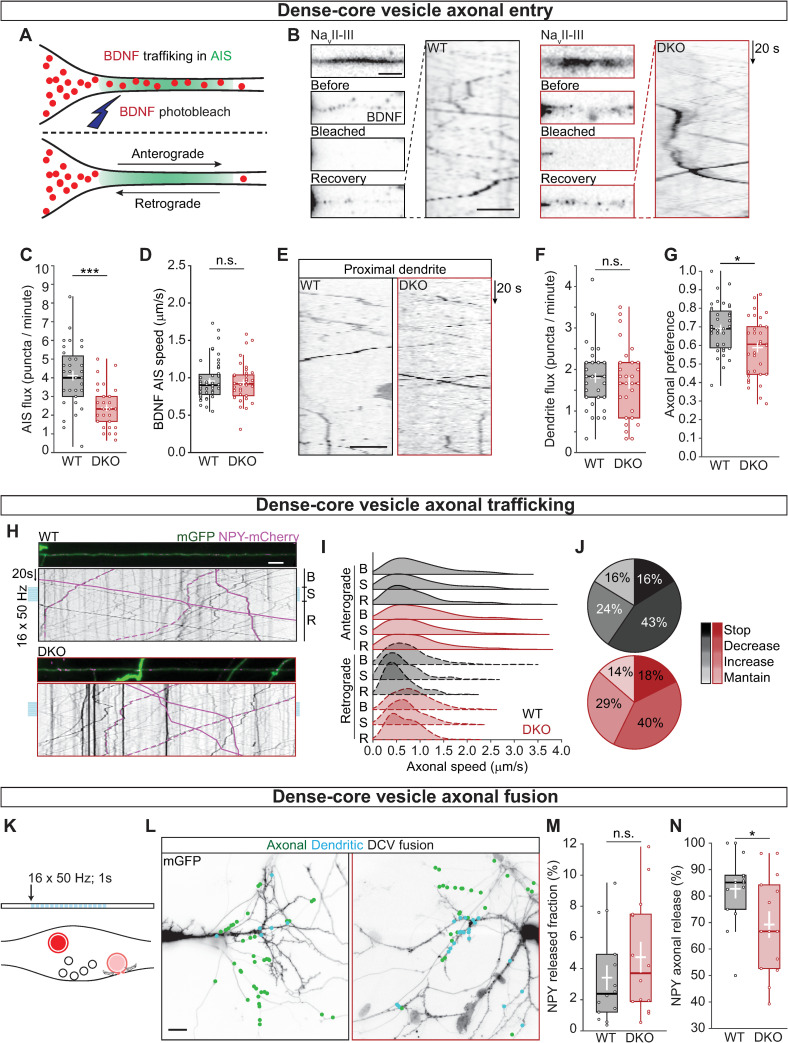
CaMKII regulates the number of DCVs entering the axon but not their trafficking properties.(A) Schematic representation of AIS targeting; NavII-III BFP was used to visualize the region of the AIS. BDNF-mCherry vesicles were bleached at the AIS to allow quantification of new vesicles entering the axon. (B) Left, typical example of AIS (top) with BDNF-mCherry-labeled DCVs before bleaching, after bleaching, and at the end of the recovery (top to bottom). Right, kymograph showing DCVs in the AIS after bleaching. (C) Quantification of DCV flux at the AIS calculated as the number of BDNF-mCherry positive puncta that enter the NavII-III BFP area per minute in anterograde (from the soma to the axon) direction. (D) Quantification of BDNF-mCherry speed at the AIS in the anterograde direction. (E) Kymograph showing DCVs in proximal dendrites after bleaching. (F) Quantification of DCV flux in the proximal dendrites in the anterograde direction. (G) Axonal preference of DCV targeting, calculated as BDNF-mCherry-positive puncta entering in the NavII-III BFP area in anterograde direction divided by the total number of BDNF-mCherry positive puncta exiting the soma. (H) Typical examples of axons labeled with mGFP showing NPY-mCherry labeled DCVs; kymographs represent axonal trafficking of NPY-mCherry in anterograde (solid lines) and retrograde (dashed lines) direction. Neurons were stimulated with 16 trains of 50 APs at 50 Hz (light blue bars). DCV speed was calculated before stimulation (B), during stimulation (S), and during recovery (R). (I) Ridgelines representing the density function of NPY-mCherry puncta speed along the axon, showing the characteristic differences in speed for anterograde and retrograde (filled and dashed density respectively) and the lower speed during stimulation. (J) Pie charts for WT (black) and DKO neurons (red) with the fraction of vesicles that stopped during stimulation (Stop), decreased their speed (Decrease), increased their speed (Increase), and maintained the same average speed (Maintain). (K) Schematic representation of DCV fusion assay. DCVs are labeled with NPY-mCherry, neurons are stimulated with 16 trains of 50 APs at 50 Hz (light blue bars). Individual DCV fusion events were quantified manually as puncta that suddenly lost their fluorescence signal. (L) Typical neurons labeled with mGFP overlaid with NPY-mCherry-labeled DCV fusion events (green dots). Axons were identified by the lack of spines. (M) Quantification of NPY-mCherry release fraction upon stimulation. (N) Quantification of the percentage of NPY-mCherry fusion events at axons. Boxplots with 95% CI whiskers, white cross shows mean ± SEM, and central bar is median. Columns and dots represent individual litters and neurons, respectively. The presented data can be found in S1 Data. *p < 0.05, **p < 0.01, ***p < 0.001. Scale bar = 5 μm (B for still frames), 10 μm (B kymograph and E), 25 μm (H), 25 μm (L). AIS, axon initial segment; AP, action potential; BDNF, brain-derived neurotrophic factor; BFP, blue fluorescence protein; CaMKII, Ca2+/calmodulin-dependent kinase II; CI, confidence interval; DCV, dense-core vesicle; DKO, double-knockout; mGFP, membrane-bound green fluorescence protein; NavII-III,voltage-gated sodium channel intracellular domain; NPY, neuropeptide Y; n. s., not significant; WT, wild type.